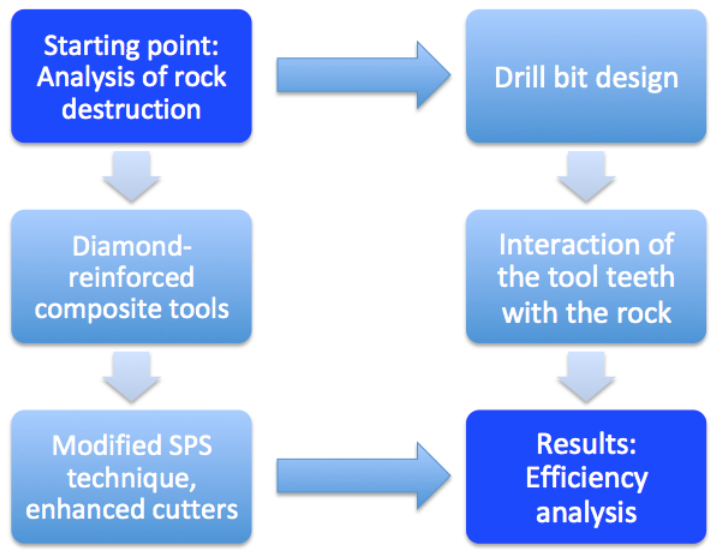
Figure 3. Main focuses of the presented research: drill bit design and the applied cutter material.